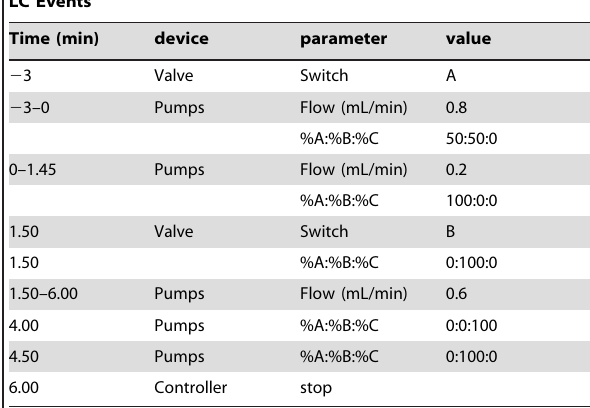
Figure 1. Chemical structure of imidacloprid .